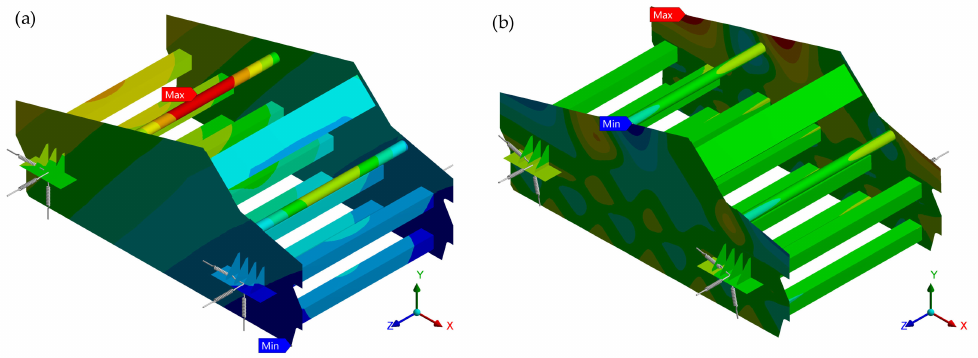
Figure 4. Vibration displacement contour map of the mining vibrating screen. ( a ) Overall vibration displacement contour map of the overall structure. ( b ) Lateral vibration displacement contour map.